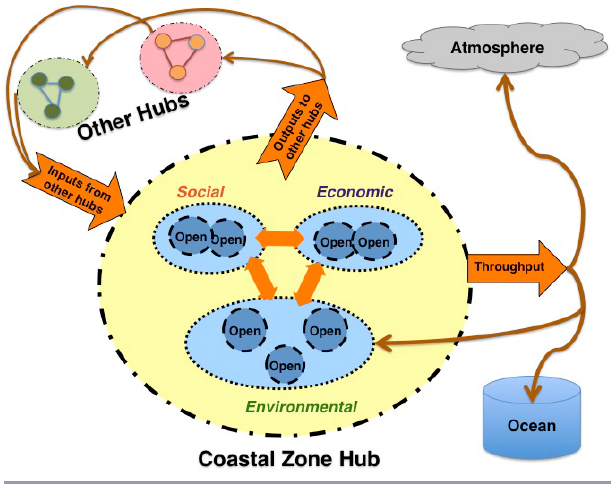
Fig. 4. Schematic of a coastal zone sustainability hub in a scale-free network. The sustainability objective is to internally minimize the combined throughput (waste) of its internal, open-system components and to connect to other external hubs such that the integrated throughput of the connected ensemble minimizes its combined throughput. Similarly, it connects with other hubs to minimize economic and social